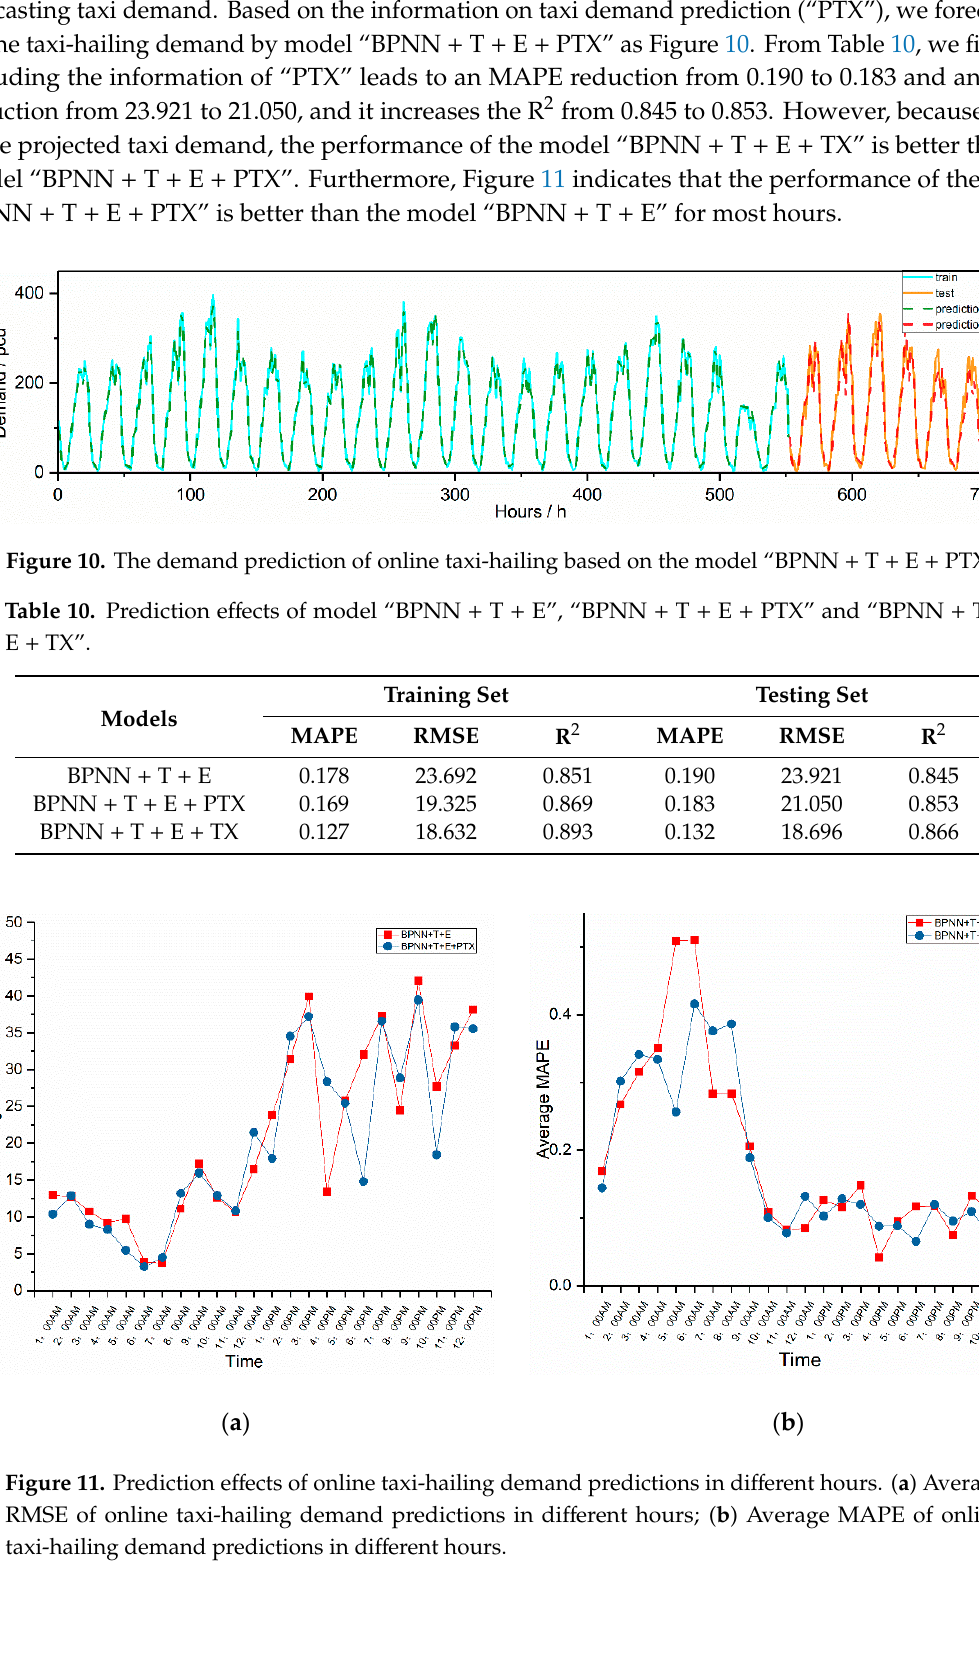
Table 9. Prediction effects of taxi demand prediction based on BPNN and XGB.